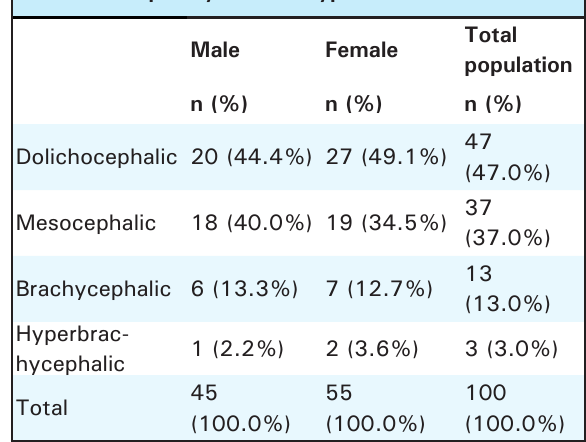
Table 2. Frequency of head types in both